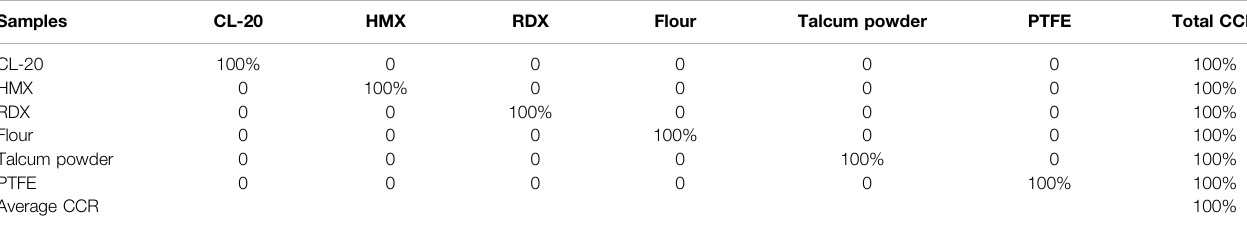
TABLE 7 | CCR of SVM4 model using the areas of six line regions.